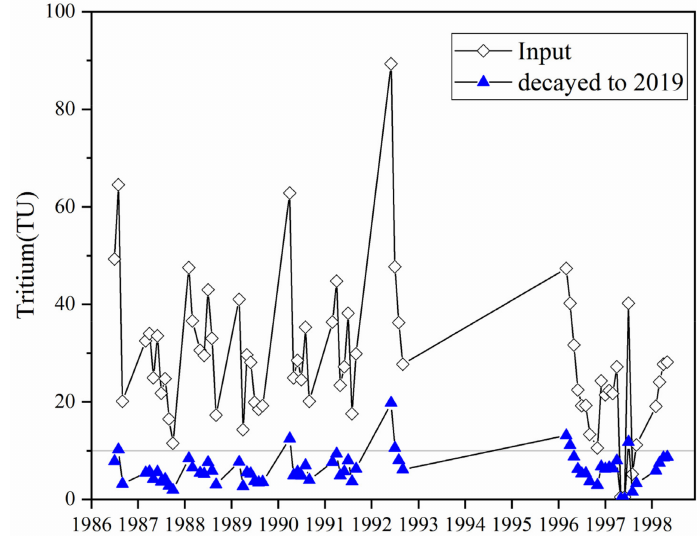
Figure 8. The tritium precipitation input from 1986 to 1998 and the decayed tritium precipitation content as of 2019 (data from GNIP Chengdu